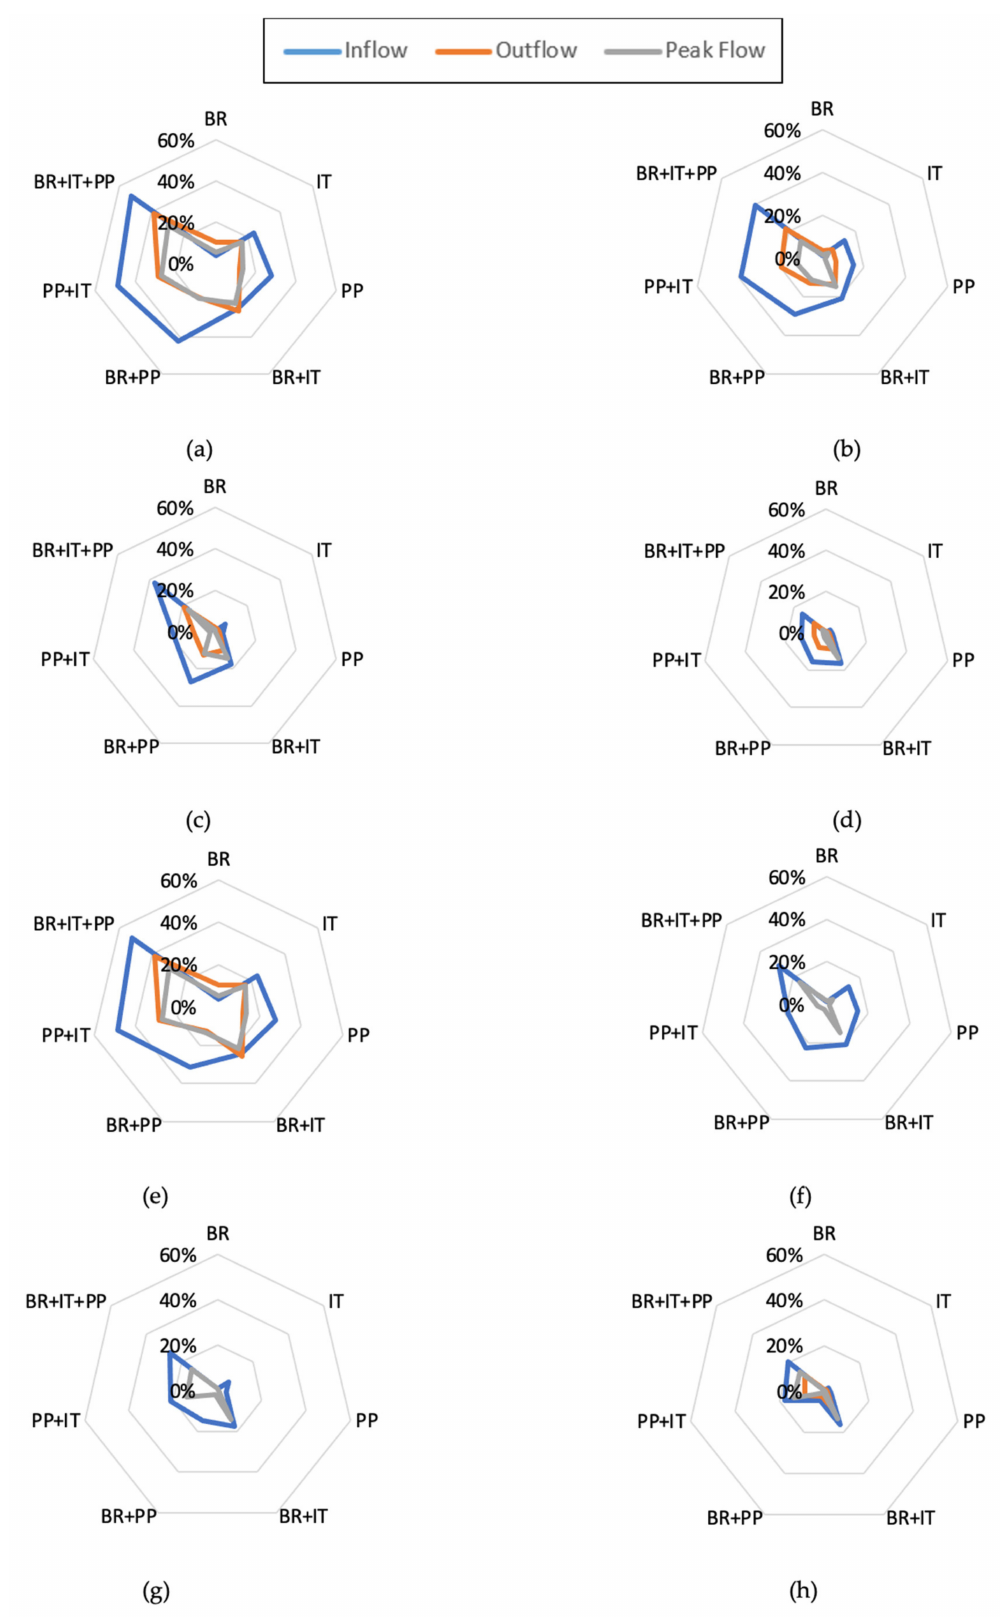
Figure 8. Reduction efficiencies of the optimal scenarios in the ( a ) 80th, ( b ), 90th, ( c ) 95th, and ( d ) 99th percentiles for the optimistic estimate and ( e ) 80th, ( f ) 90th, ( g ) 95th, and ( h ) 99th percentiles for the pessimistic